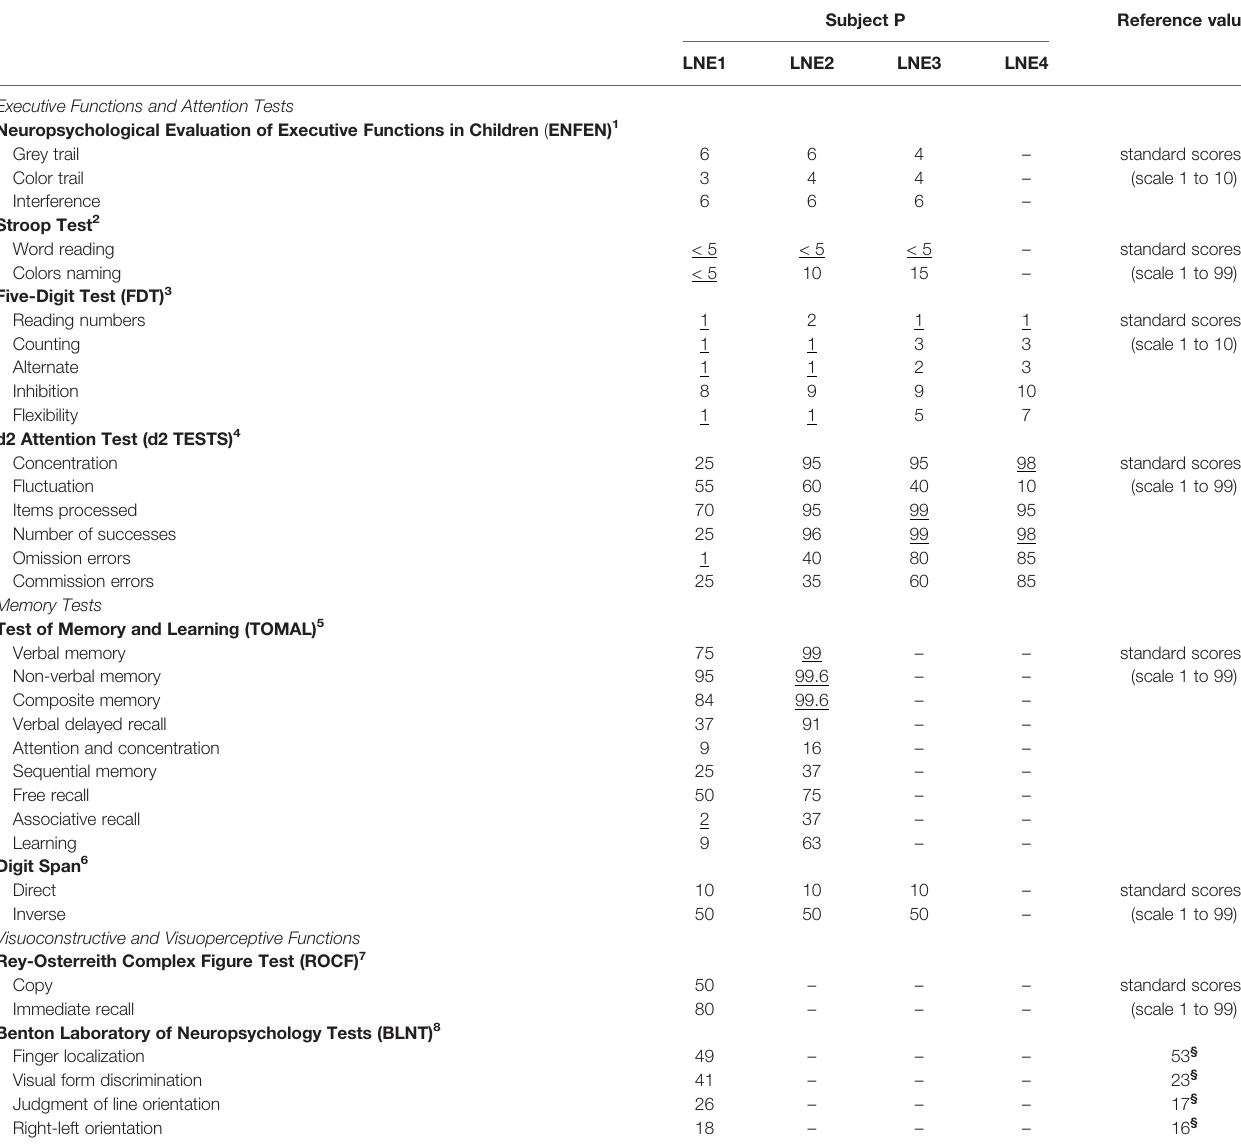
TABLE 2 | Neuropsychological